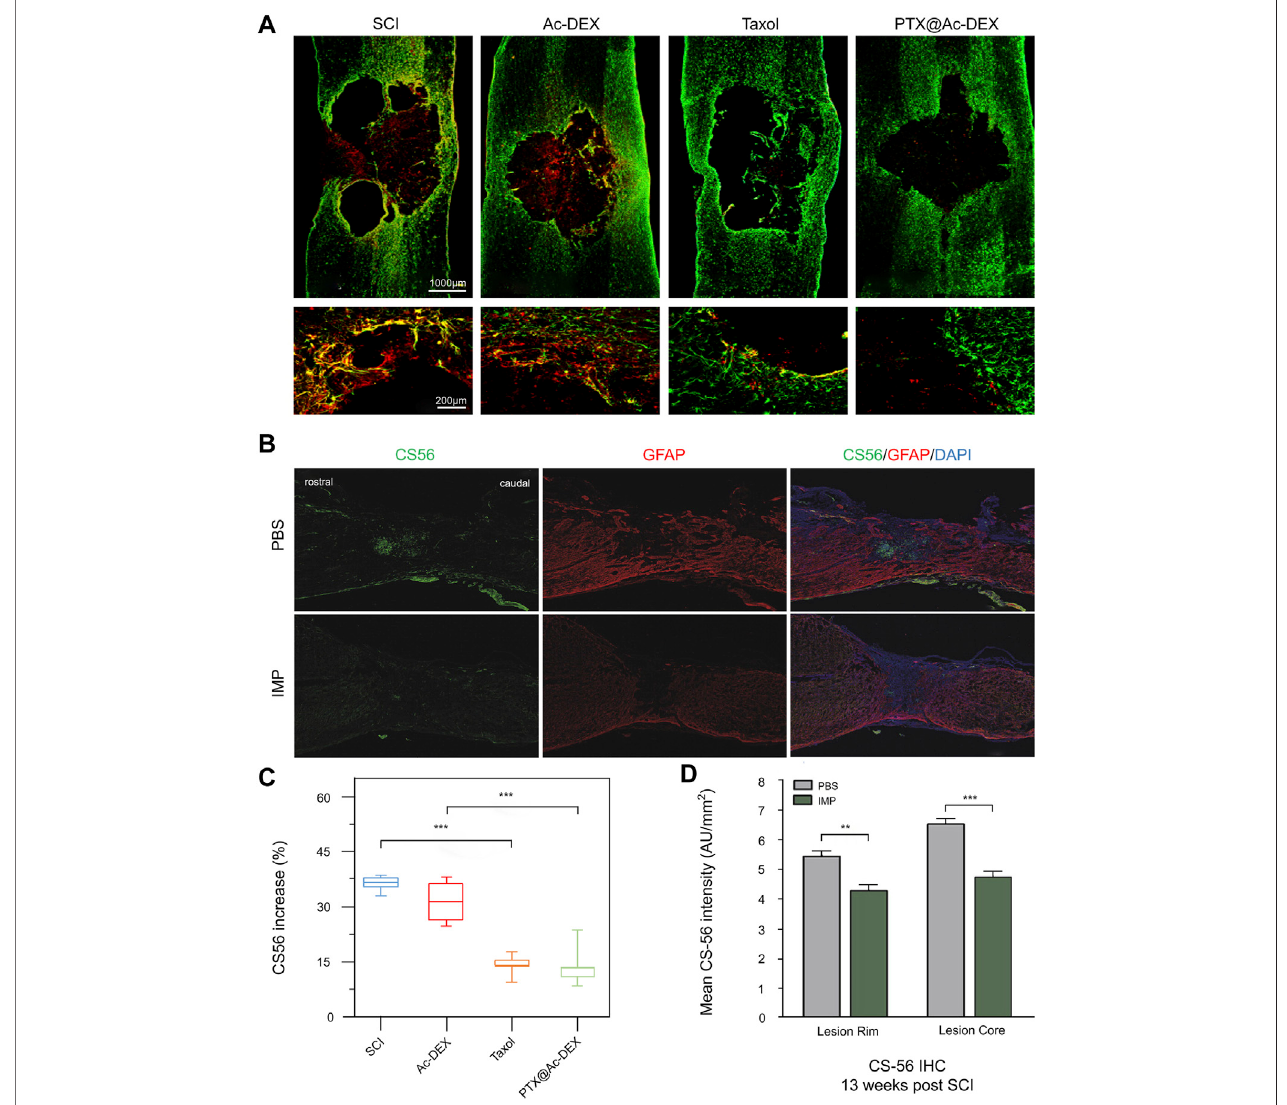
FIGURE 7 | Regulation of undesirable components in extracellular matrix by biomaterials. (A) Immunohistochemical staining of CS56 (red) and GFAP (green) at 28 days after injury. (B) 13 weeks after SCI, PBS and IMP groups were immunostained with CS-56 and GFAP. (C,D) Cs-56 quantitative analysis of lesion area. Reproduced with permission from (119,